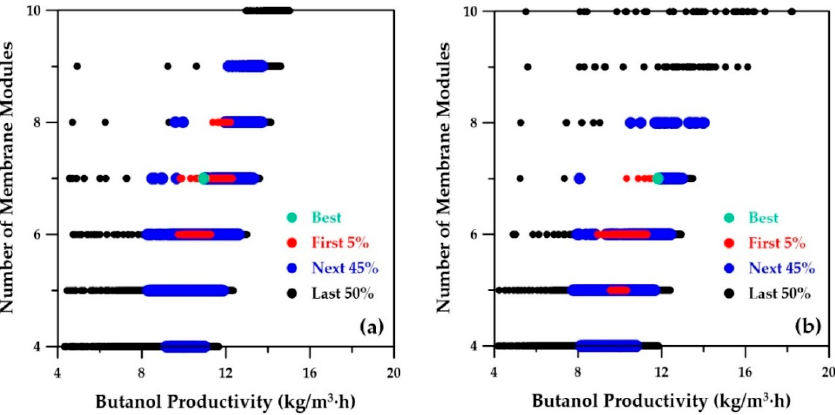
Figure 9. Plots of sugar conversion versus butanol productivity for the integrated fermentation– membrane pervaporation system: ( a ) ANN metamodels; ( b ) actual integrated system simulation.